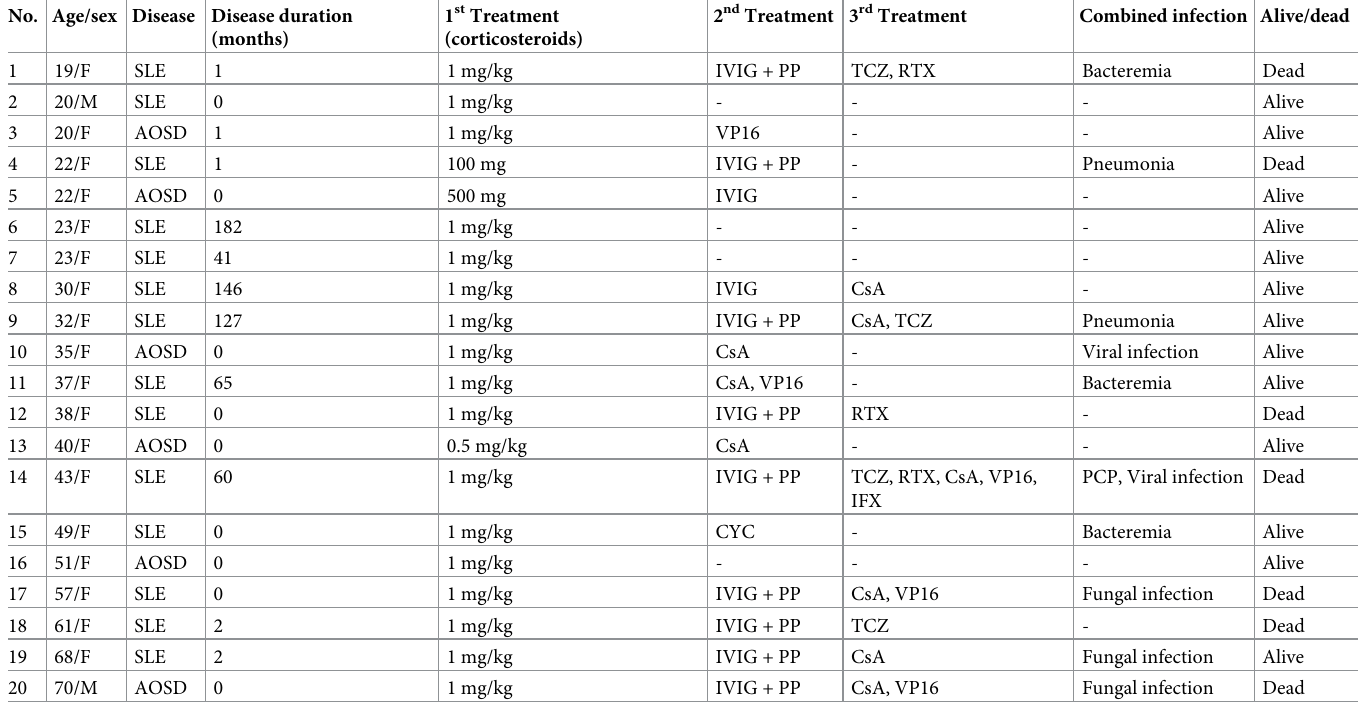
Fig 1. Overall survival (A) and mortality (B) of patients with MAS within 6 months MAS: Macrophage activation syndrome, AOSD: Adult-onset still’s disease, SLE: Systemic lupus erythematosus. https://doi.org/10.1371/journal.pone.0267715.g001 major underlying rheumatic diseases, and half of the cases presented with MAS as an initial manifestation. As there are no diagnostic markers for MAS, it was difficult to identify in patients with rheumatic disease. Several classification criteria or score systems have been used for the identi- fication of MAS, including the HLH-2004 or EULAR/ACR/PRINTO criteria, however, there remain no defined diagnostic criteria [2, 5, 6]. Leukopenia and thrombocytopenia, both of which are included in the HLH criteria, can even be observed in patients with SLE who have stable disease. Otherwise, as leukocytosis is typical manifestation in patients with AOSD, Table 3. Treatments and management characteristics of patients with